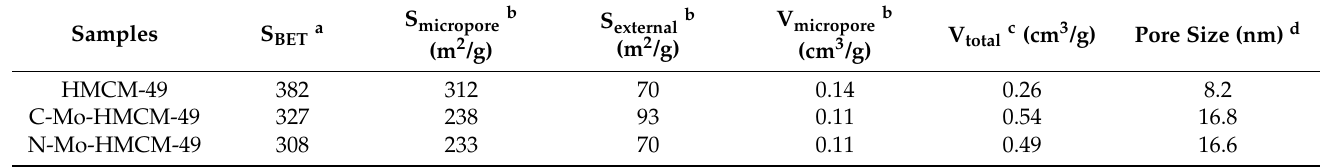
Table 1. The textural properties of HMCM-49, C-Mo-HMCM-49, and N-Mo-HMCM-49.